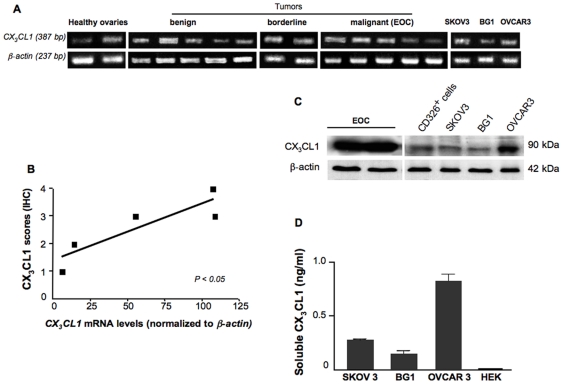
Steady-state levels of CX3CL1 products in healthy and malignant ovaries.(A) CX3CL1 mRNA was detected by conventional PCR at the expected size (387 bp) in representative specimens from 2 healthy ovaries, 5 cystadenomas (benign tumors), 2 borderline tumors, 5 adenocarcinomas (malignant tumors) and in the EOC-derived cell lines, SKOV3, OVCAR3 and BG1. The white vertical line separates lanes not run on the same gel. (B) CX3CL1 mRNA levels were quantified by real-time PCR and are expressed as CX3CL1 content normalized to that of ß-actin. The diagram shows the distribution of immunostaining scores versus the amount of CX3CL1 mRNAs normalized to those of ß-actin for 5 EOC samples. Each symbol represents an individual sample run in triplicate (mean value); Spearman's test, P<0.05, r = 0.88. (C) CX3CL1 immunoblots of total protein lysates from EOC specimens, from CD326+ epithelial cell-enriched malignant ascites samples, and from SKOV3, BG1 and OVCAR3 cell lines. The CX3CL1 protein is indicated as a ∼90 kDa band. ß-actin levels are shown for normalization. (D) Detection by ELISA of sCX3CL1 in the 24 h culture medium of BG1, OVCAR3 and SKOV3 cells (data are means ± SEM of three separate experiments); undetectable sCX3CL1 in the culture medium of HEK-293T cells (HEK), used as a negative control.